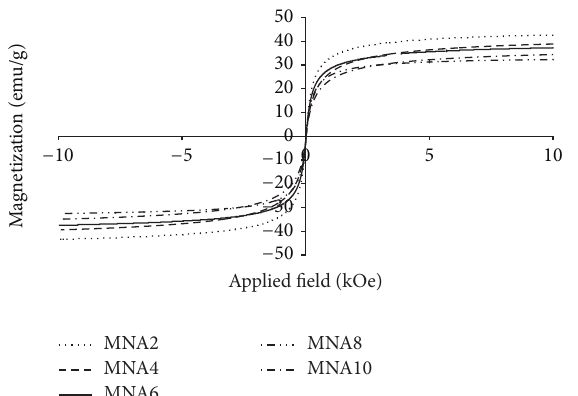
Figure 6: DLS measurement of maghemite nanoparticles for all samples.